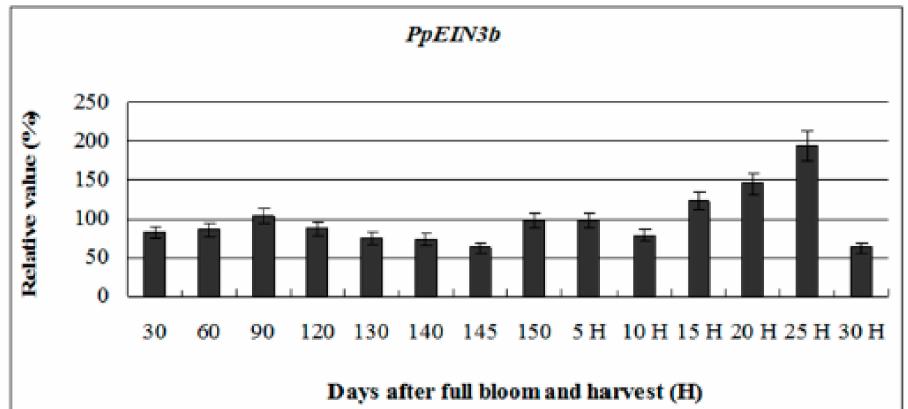
Figure 4. qRT-PCR analysis of expression of PpEIN3b during fruit development. Relative value of expression of PpEIN3b in pear fruit is shown as percentage of PpUBI expression. Mean values and SD (bar) are shown from three independent experiments.